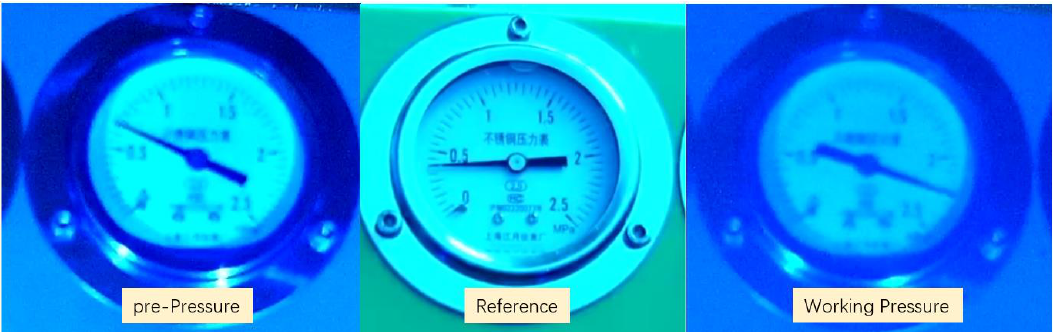
Figure 17. Pressure of arm cylinder during the 2019 sea trials.